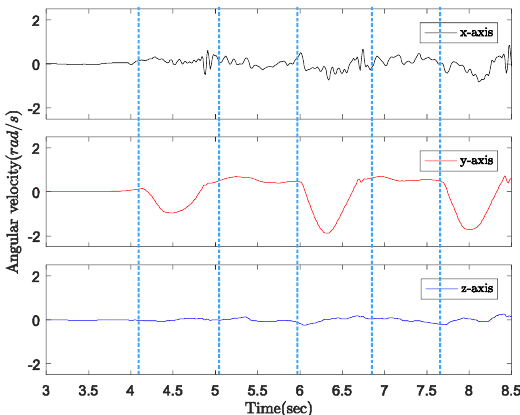
Figure 9. Three-axis angular velocity from gyroscope output with standard cane.